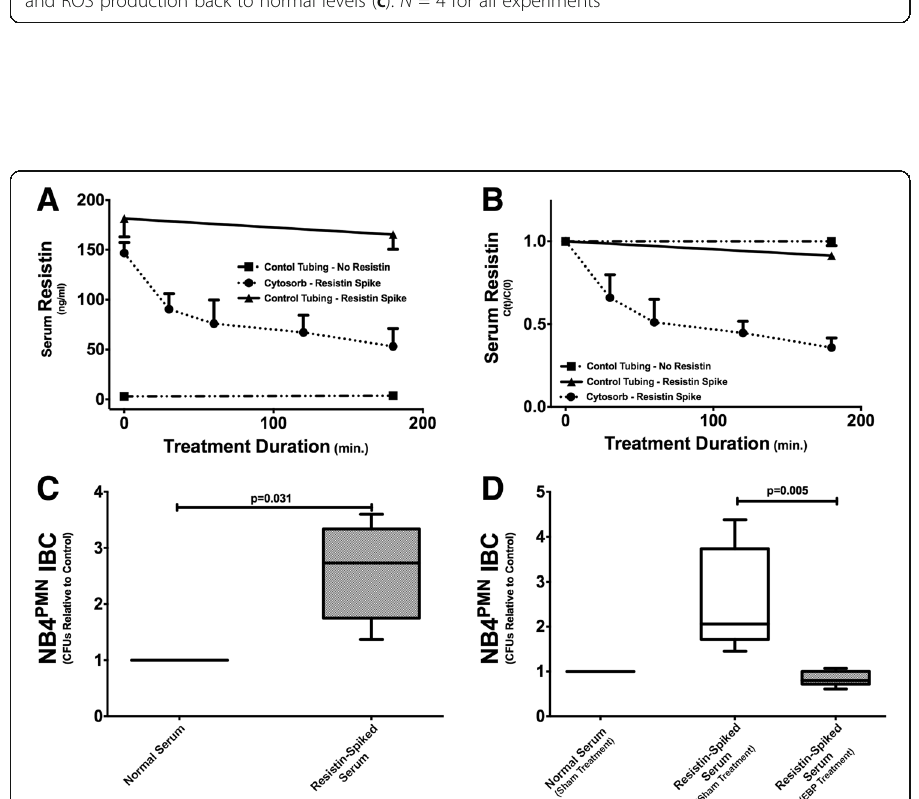
Fig. 5 Hemoadsorption treatment with Cytosorb ™ corrects hyperresistinemia by removing more than 50% of excessive resistin from resistin-spiked serum ( a , b ). Incubation of NB4 PMN cells in resistin-spiked serum prior to hemoadsorption treatment reveals impaired intracellular P. aeruginosa clearance compared to incubation in control serum ( c ). However, incubation of NB4 PMN cells in resistin-spiked serum after hemoadsorption treatment shows restitution of normal intracellular bacterial clearance ( d